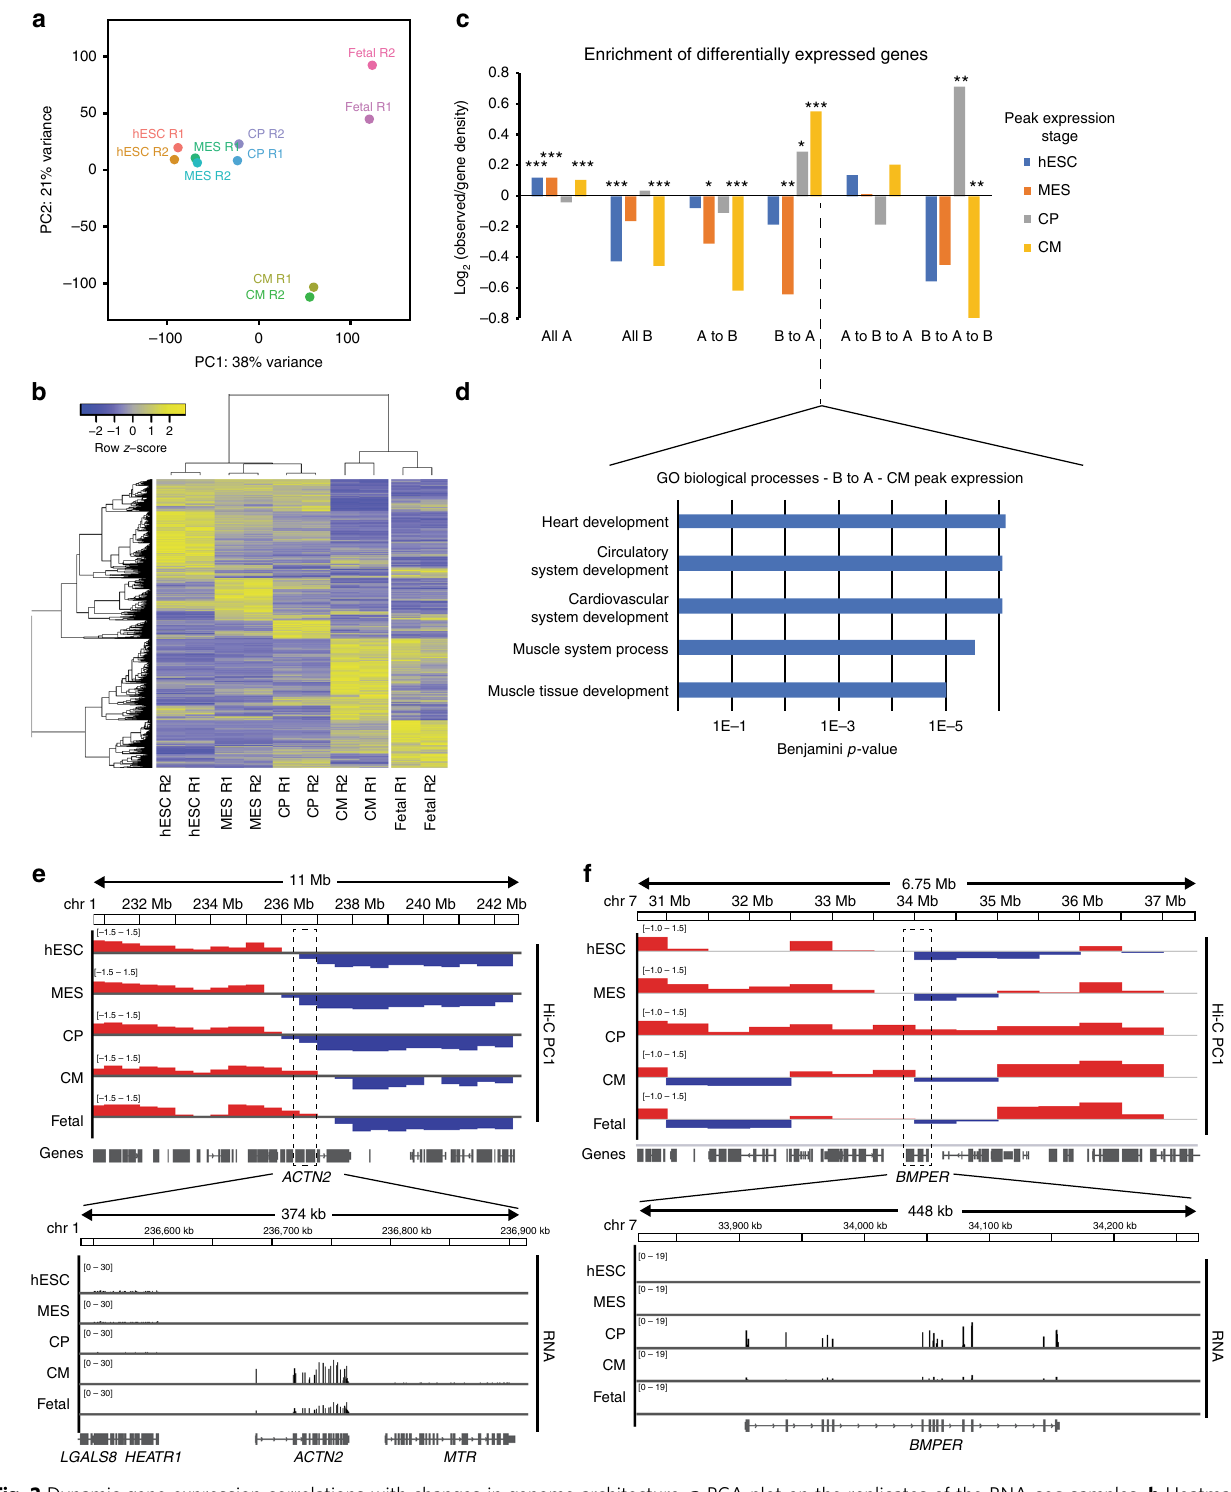
Fig. 2 Dynamic gene expression correlations with changes in genome architecture. a PCA plot on the replicates of the RNA-seq samples. b Heatmap of the differentially expressed genes during differentiation, clustering of rows based on differentiation time points. c Enrichment of differentially regulated genes by time point of peak expression against A/B compartment dynamics. Log 2 values are observed/gene density; p -values by chi-squared test for the indicated gene set overlaps, * < 0.05, ** < 0.01, *** < 0.001. d GO term enrichment in CM peak expression genes in B to A compartments, p -value plotted on log scale. e Gene track of Hi-C PC1 and RNA-seq reads of ACTN2 . f Gene track of Hi-C PC1 and RNA-seq reads of BMPER . Source data are provided as a Source Data fi